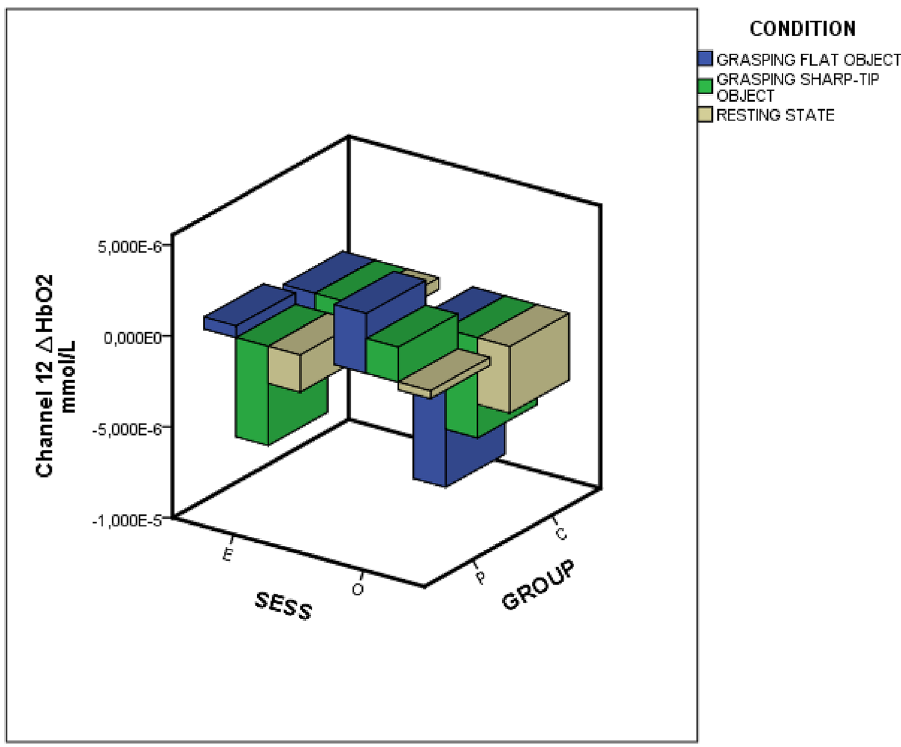
Figure 4. Oxyhemoglobin levels on an exemplificative channel (channel 12). Sess session, O observation-only session, E time-to-contact detection session, P FM patients, C controls.